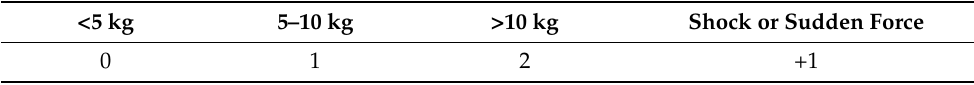
Table 8. Evaluation of handling